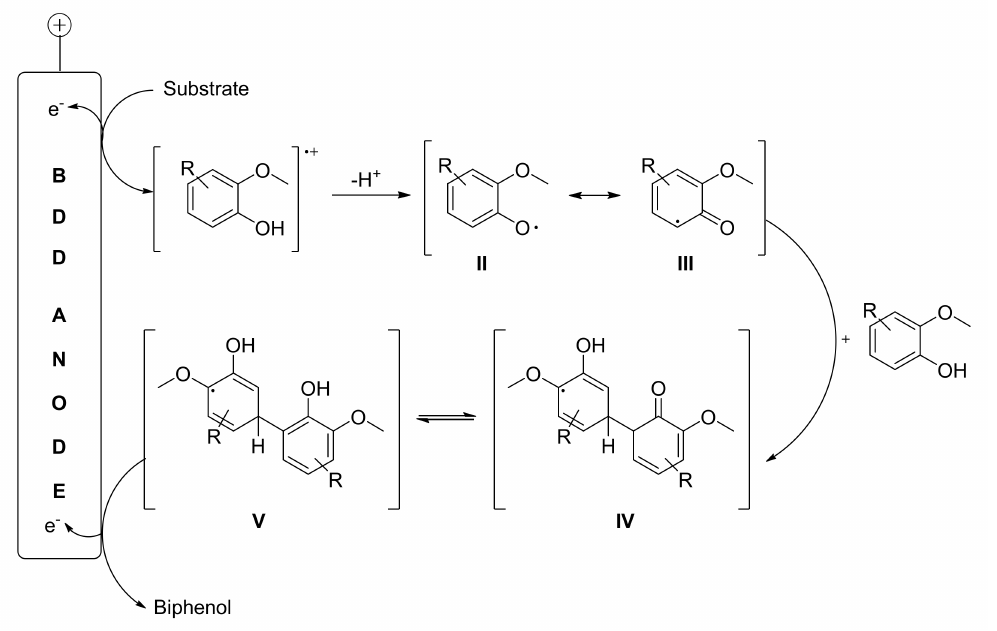
Scheme 3. Proposed mechanism for guaiacol anodic